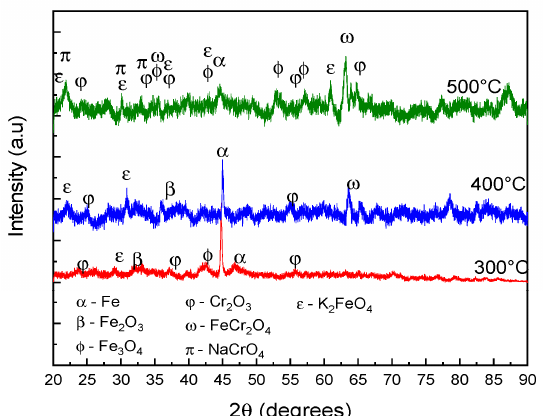
Figure 11. X-ray patterns of corrosion products for T91 steel corroded in 60 wt% NaNO 3 -40KNO 3 at 300, 400 and 500 °C.